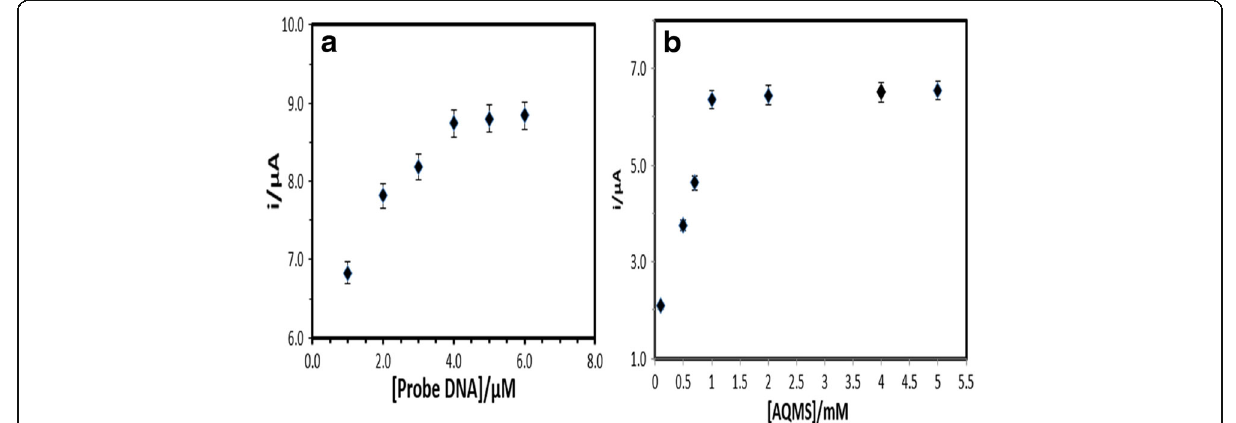
Fig. 4 The effect of capture probe ( a ) and AQMS concentrations ( b ) on the DNA biosensor response performed with 5 μ M cDNA and signal probe in 0.05 M sodium phosphate buffer (pH